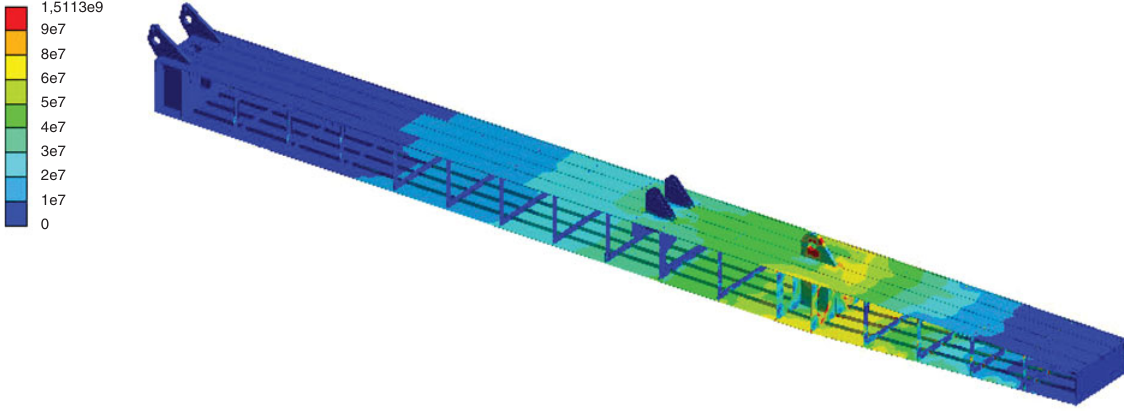
Fig. 8. Trolley with container is at the end of console. Stress state of console (Von Misses,